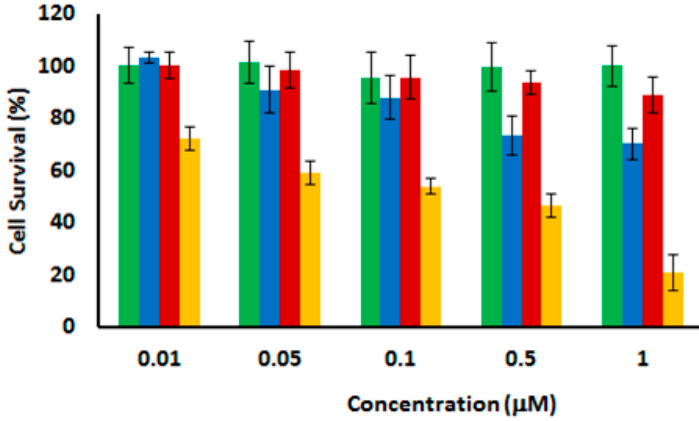
Figure 5. Phototoxicity of C-TCPP-PSilQNPs ( green ) and RR-TCPP-PSilQNPs ( red ) in the absence of light, and C-TCPP-PSilQNPs ( blue ) and RR-TCPP-PSilQNPs ( orange ) after light exposure (630–700 nm; 89 mW/cm 2 ; 20 min). Error bars represent the standard deviation of three independent experiments with six repetitions each.